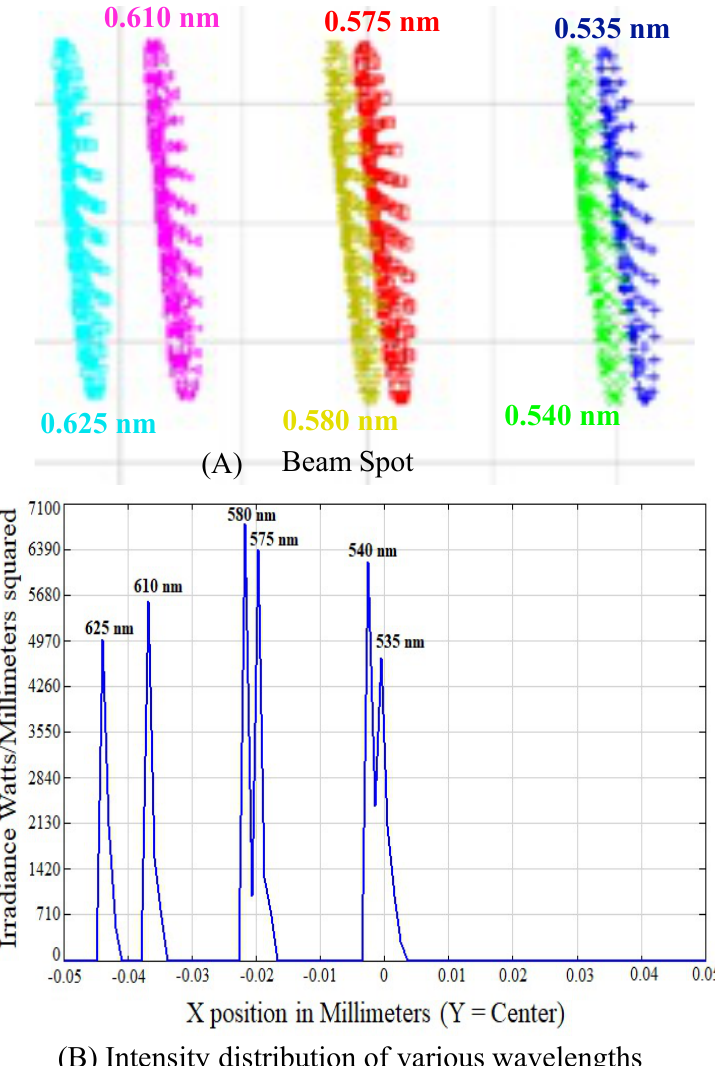
Figure 2. ( A ) Spot diagram of 535 nm (blue), 540 nm (green), 575 nm (red), 580 nm (gold), 610 nm (purple) and 625 nm (sky blue). ( B ) Intensity distribution at various wavelengths: 535 nm, 540 nm, 575 nm, 580 nm, 610 nm and 625